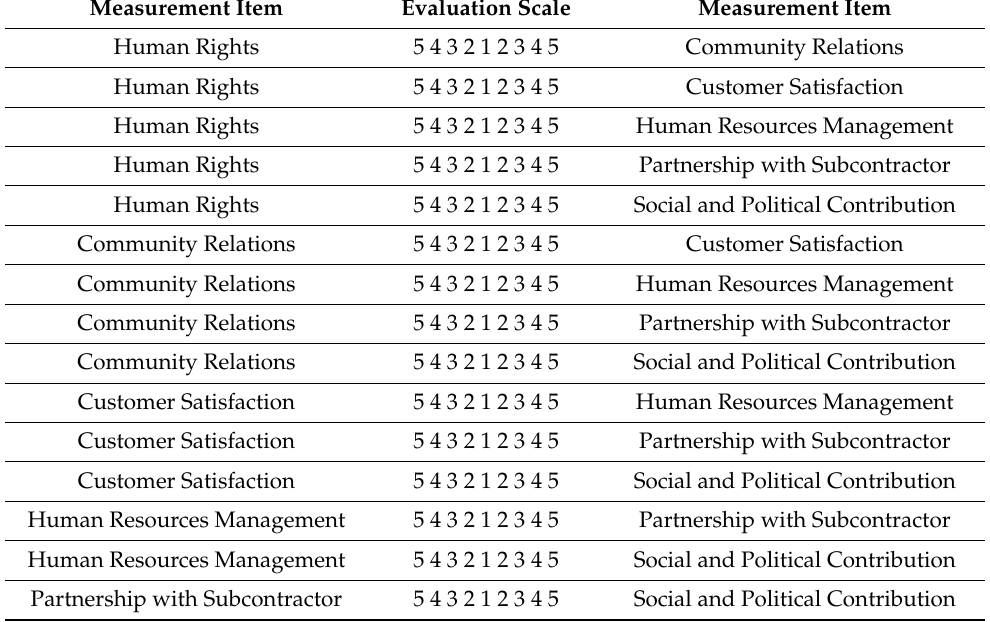
Table A8. Social factor question